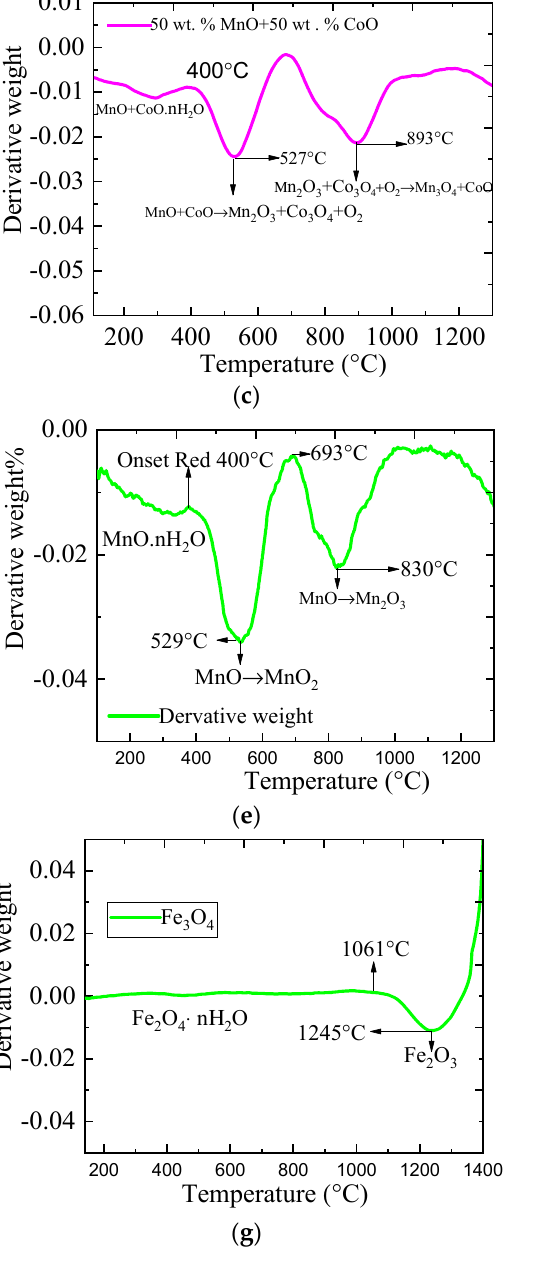
Figure 2. Weight derivative graphs (WDG) for mixed and pure metallic oxides at 30 mL Ar/min and 20 mL O 2 /min gas flow rates subjected to heating from 30 to 1400 °C (at 30 °C/min heating rate) step 1 redox: ( a ) WDG for all oxides under the test; ( b ) WDG for mixed oxides of 75 wt.% MnO + 25 wt.% CoO with temperature; ( c ) WDG for mixed oxides of 50 wt.% MnO + 50 wt.% CoO with temperature; ( d ) WDG for mixed oxides of 25 wt.% MnO + 75 wt.% CoO with temperature; ( e ) t WDG for MnO with temperature; ( f ) WDG for CoO with temperature; ( g ) WDG for Fe 3 O 4 CoO with temperature; ( h ) WDG t for mixed oxides of 25 wt.% MnO + 75 wt.% CoO and 50 wt.% MnO + 50 wt.% CoO with temperature in the first step of redox.